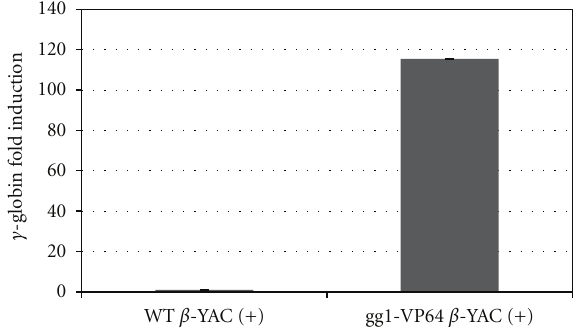
Figure 5: γ -globin gene expression in phenylhydrazine-treated samples from gg1-VP64 β -YAC bigenic mice. Total RNA isolated from adult spleen was subjected to qPCR analysis using SYBR Green. Primers for human γ -globin were utilized, and the data was normalized to mouse α -globin or Gapdh gene expression. Results are the average of 3 replicates of the gg1-VP64 β -YAC bigenic mouse ± the standard error of the mean